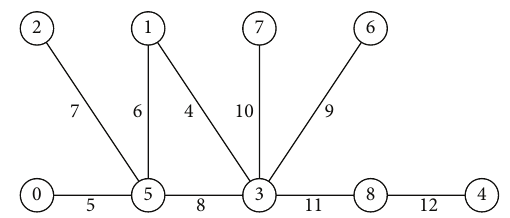
Figure 2: Strongly 4 -harmonious labeling of a unicyclic